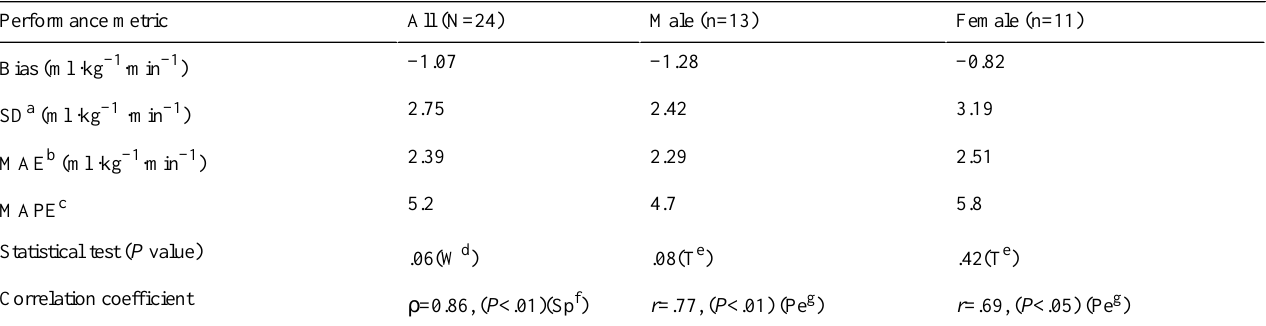
Table 3. Maximal oxygen uptake (VO 2Max ) estimated from optical heart rate data and based on measured maximum heart rate value.